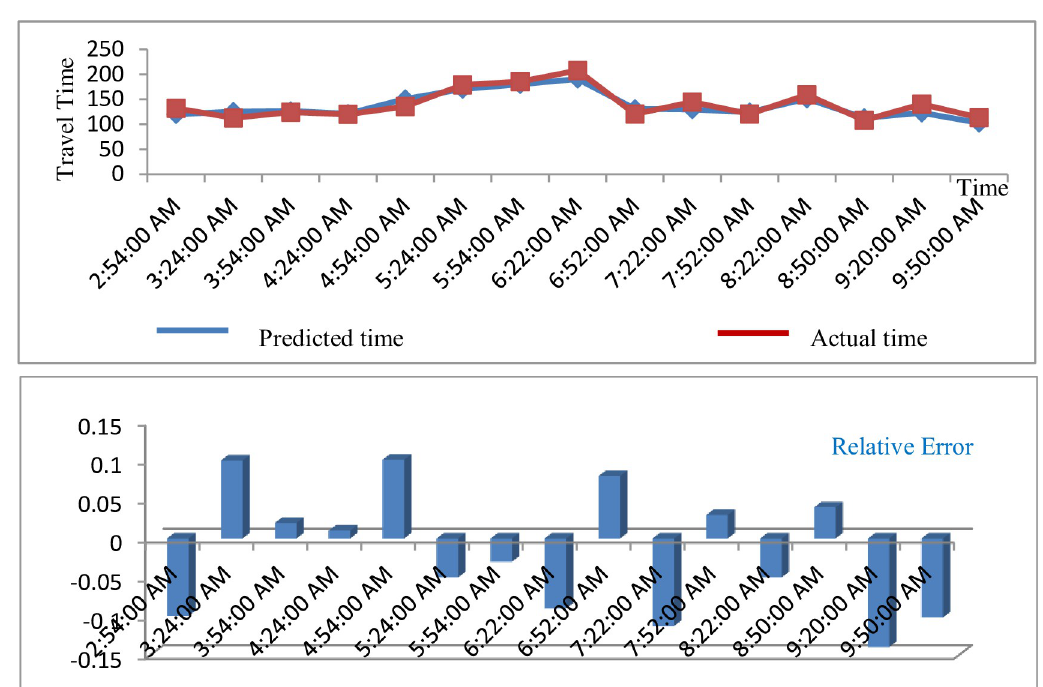
Fig 6. Predicted result of travel time (route segment 2).